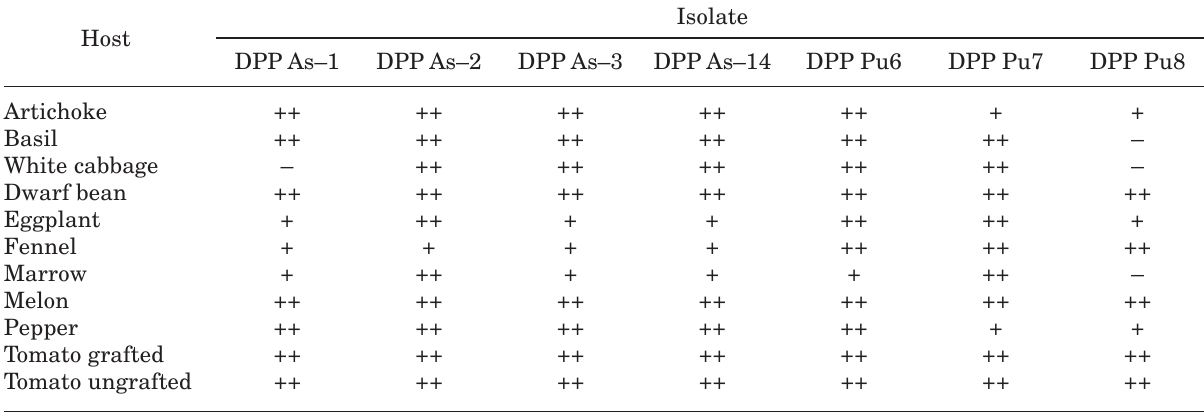
Table 1. Results of experimental infection on different host plants tested with Erwinia carotovora ssp. carotovora tomato